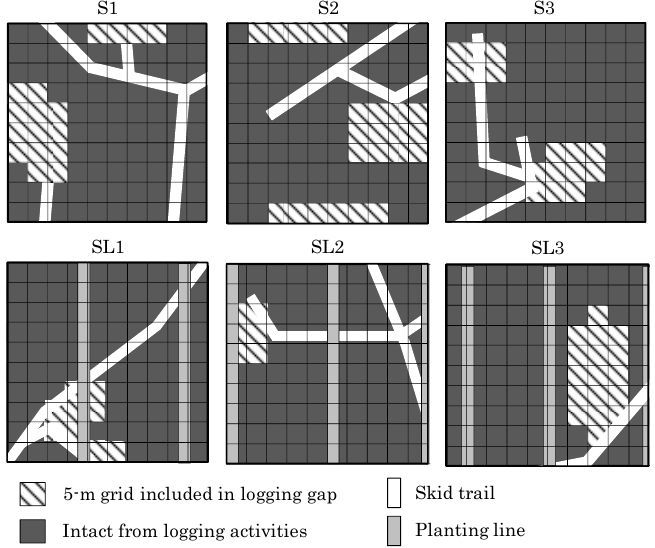
Figure 2. Logging trails in each quadrate at the S and SL sites.